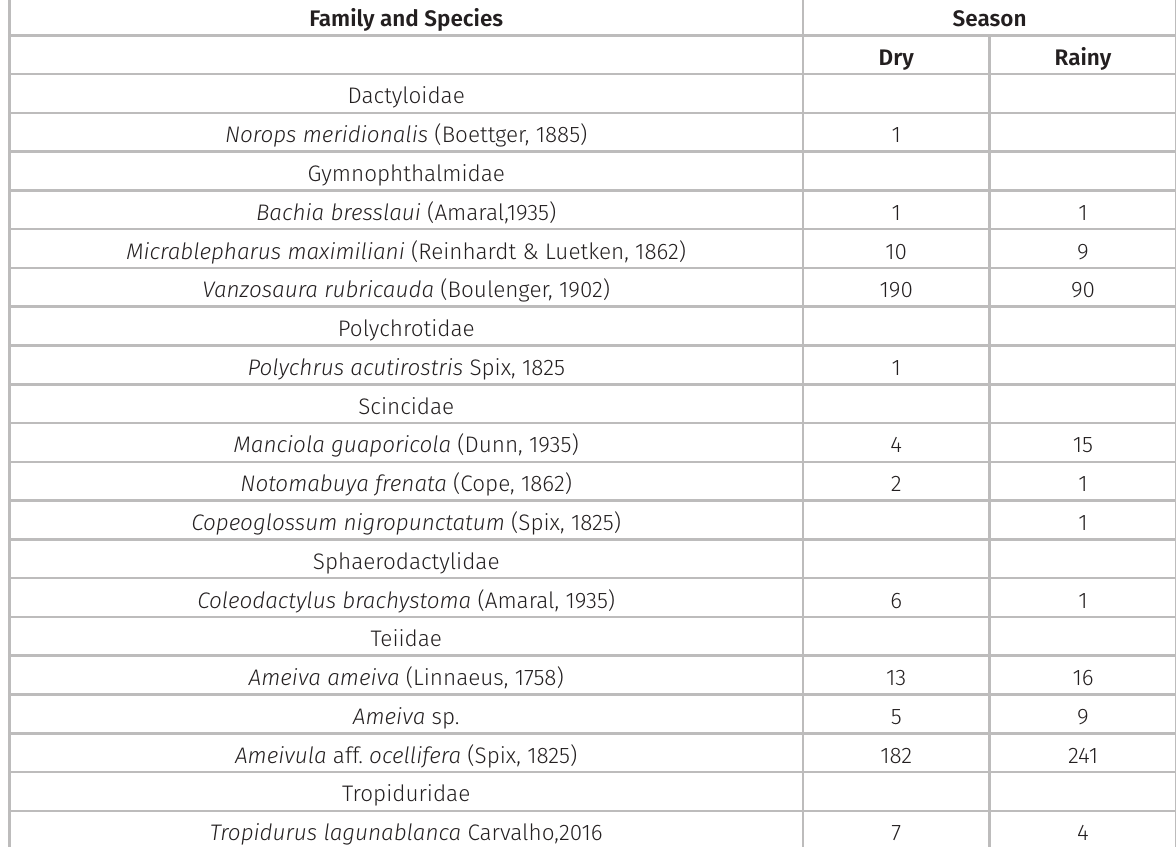
Table I. Composition and abundance of lizard communities by season in the Nhumirim Ranch in Pantanal, Brazil, from February 2005 and March